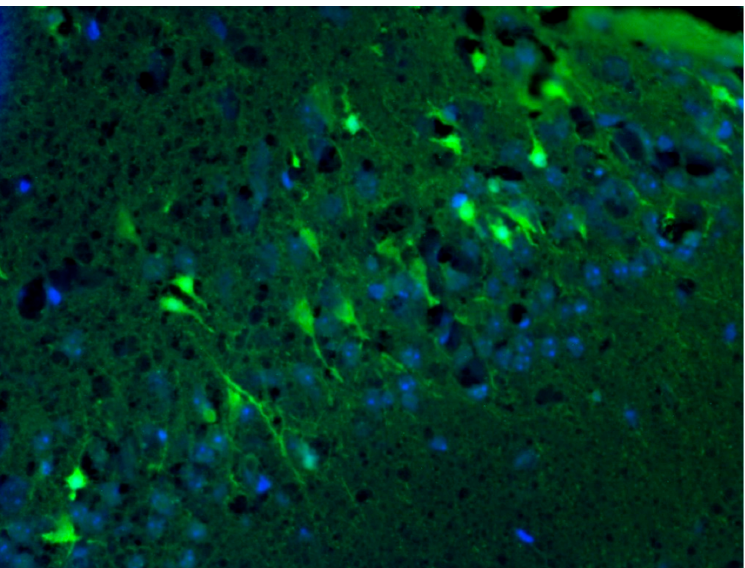
Figure 8. Localization of brain neurodegeneration in the site of KA delivery. Damaged neurons were stained using Fluoro-Jade C (light green color). Cell nuclei are counterstained with DAPI (blue color).